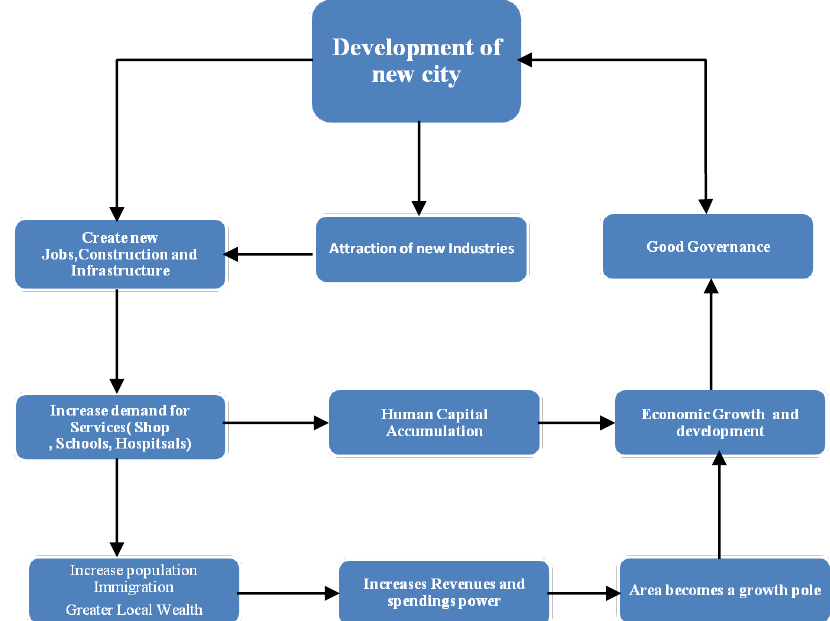
Figure 4. Channels of Core-Periphery